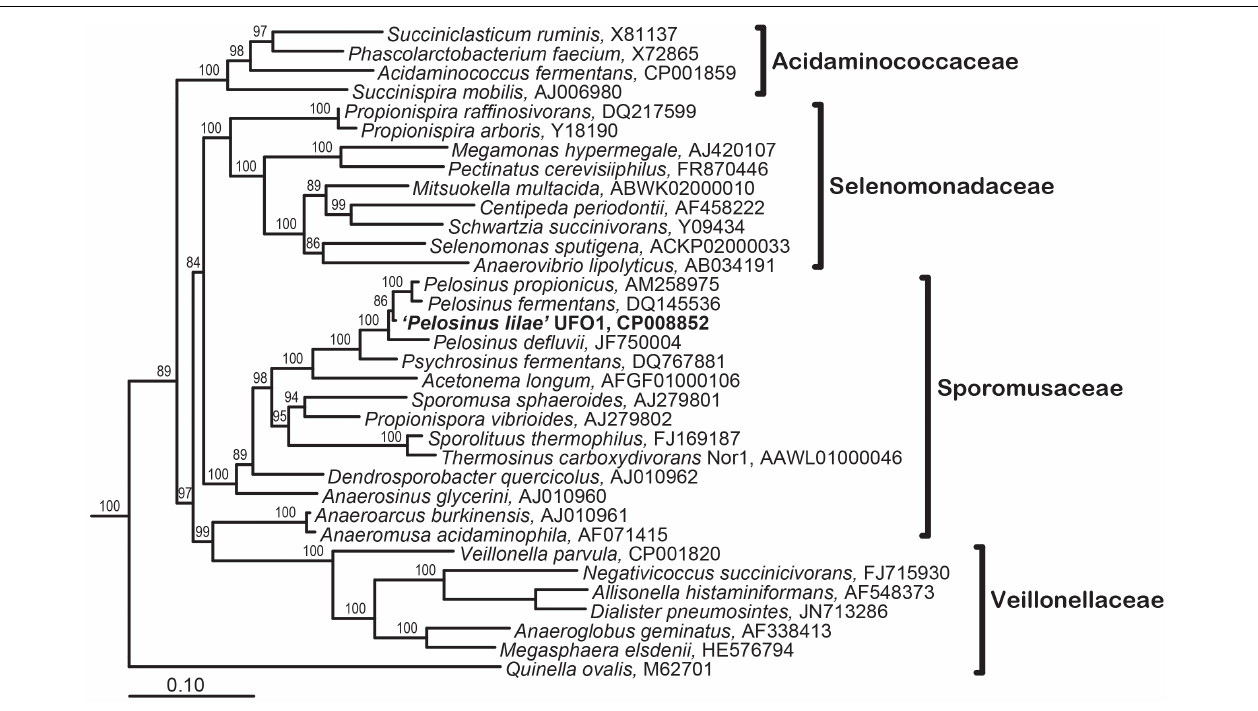
FIGURE 5 | Maximum Likelihood tree showing phylogenetic relationships of the 16S rRNA genes in the Class Negativicutes; the types species for each genus in the four families within this class is included. Branch supports determined by Bayesian estimation ≥ 80 are shown at branch points. Scale bar indicates 0.1 changes per nucleotide. Tree was rooted with 4 species (not shown): Bacillus subtilis (AB042061), Clostridium acetobutylicum (AE001437), Desulfotomaculum acetoxidans (Y11566), and Heliobacillus mobilis (AB100835).